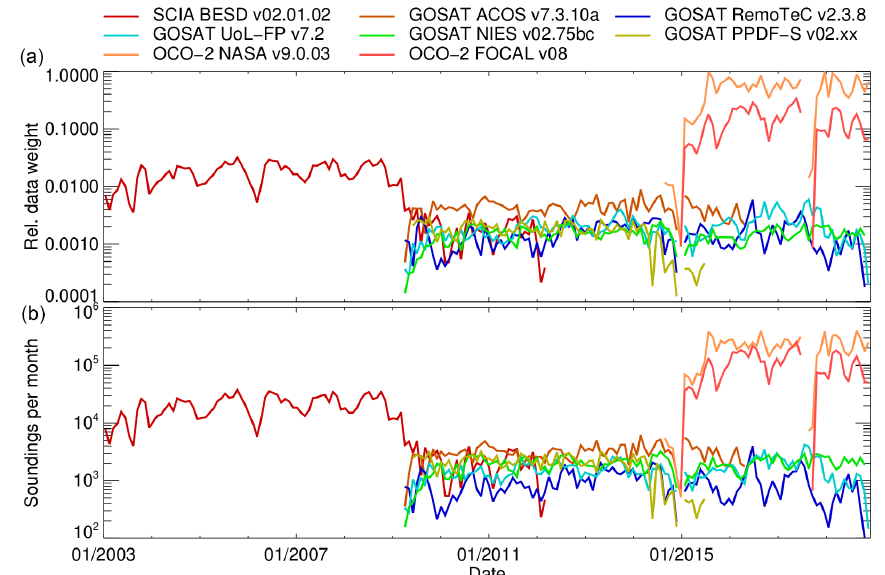
Figure 6. Relative data weight (a) and soundings per month (a) of the individual satellite XCO 2 data products contributing to the EMMA XCO 2 data product.